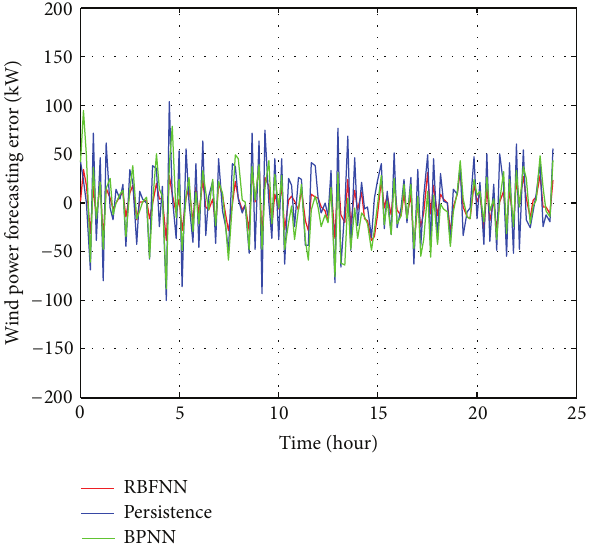
Figure 11: The forecasting error curve of three methods for typical summer